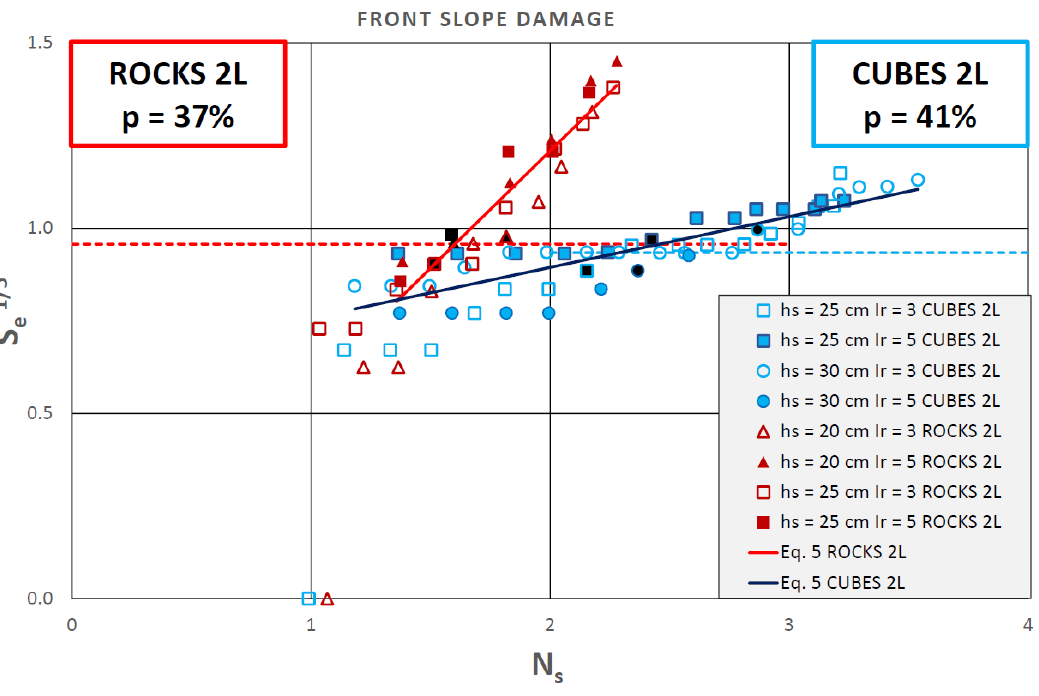
Table 3. Calibrated values of k 1 and k 2 for Equation (5) and rMSE and r values. Armor Layer